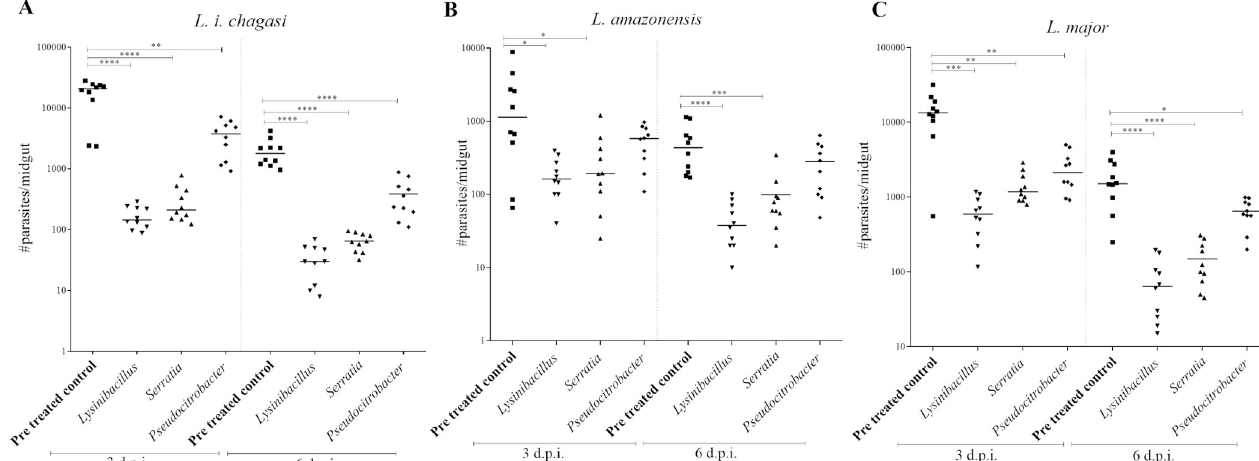
Fig 4. Co-infection with the native bacteria and the effect in the live parasite. In vivo co- infection of L . i . chagasi (A), L . amazonensis (B), and L . major (C) with the genera Lysinibacillus , Pseudocitrobacter , or Serratia affect live parasite counts. The sandflies were infected by artificial feeding with 4 × 10 6 mL logarithmic phase promastigotes and bacterial isolates at 1 x 10 8 / mL. Three and six days post-infection the midguts were individually macerated Moreover, the number of parasites alive counted under a hemocytometer.